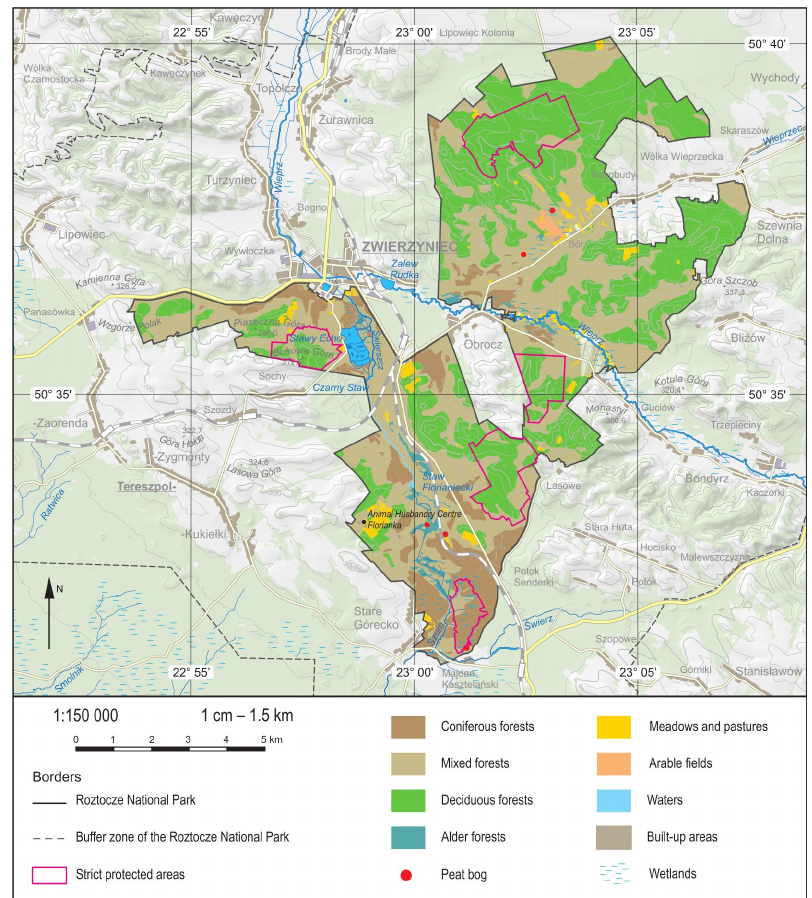
Figure 2. Land-use structure in the Roztocze National